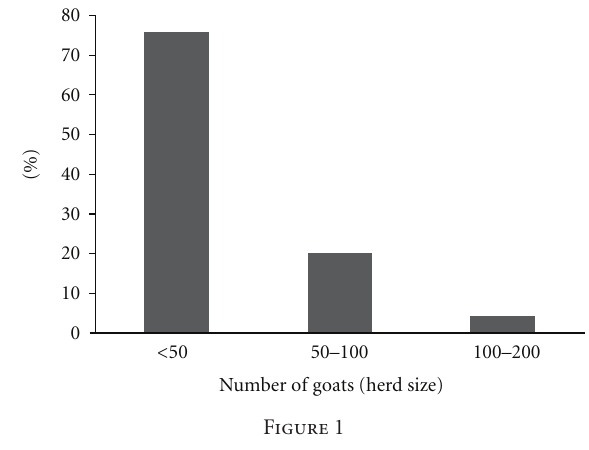
jugular venipuncture using plain 10 mL Vacutainer (Becton, Dickinson and Co., Franklin Lakes, NJ, USA) tubes.